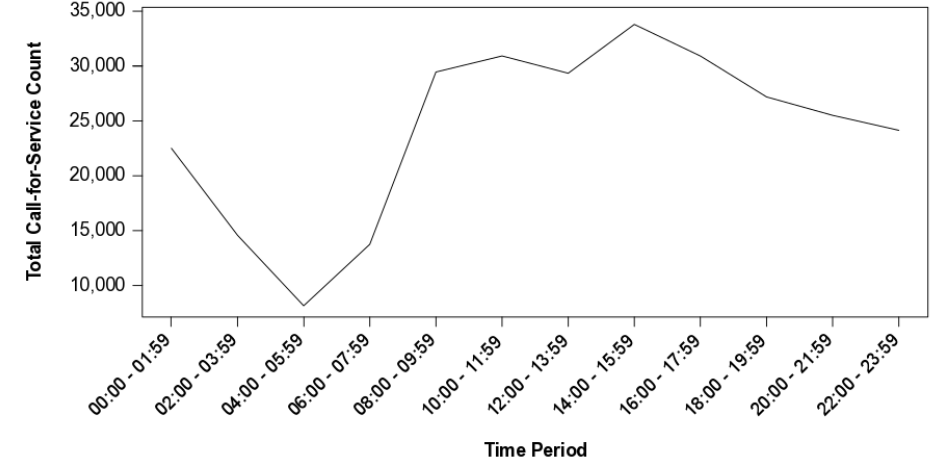
Figure 2. Total calls-for-service by 2 hour time period.